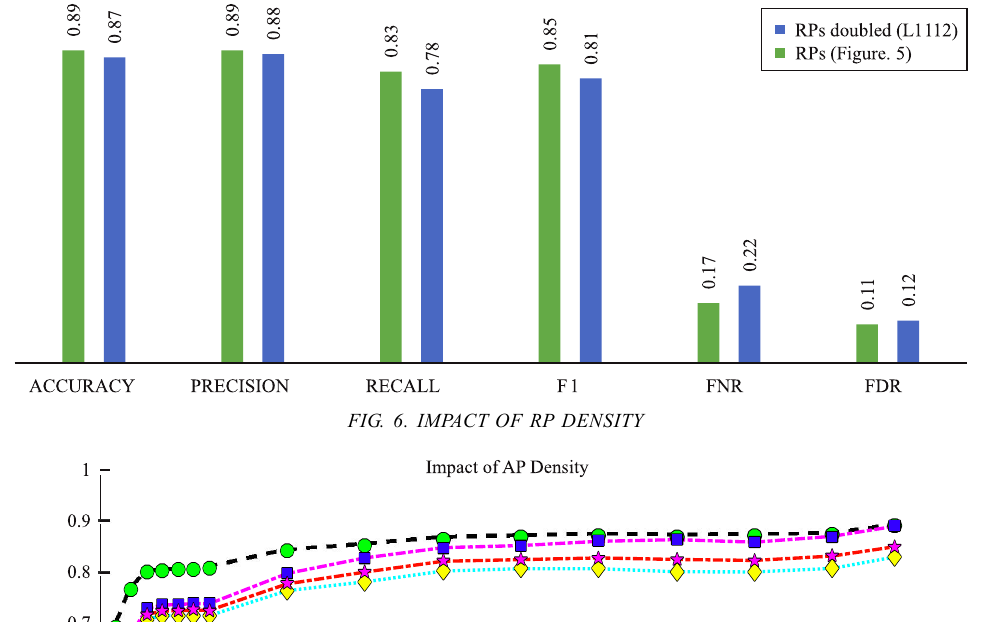
FIG. 6. IMPACT OF RP DENSITY